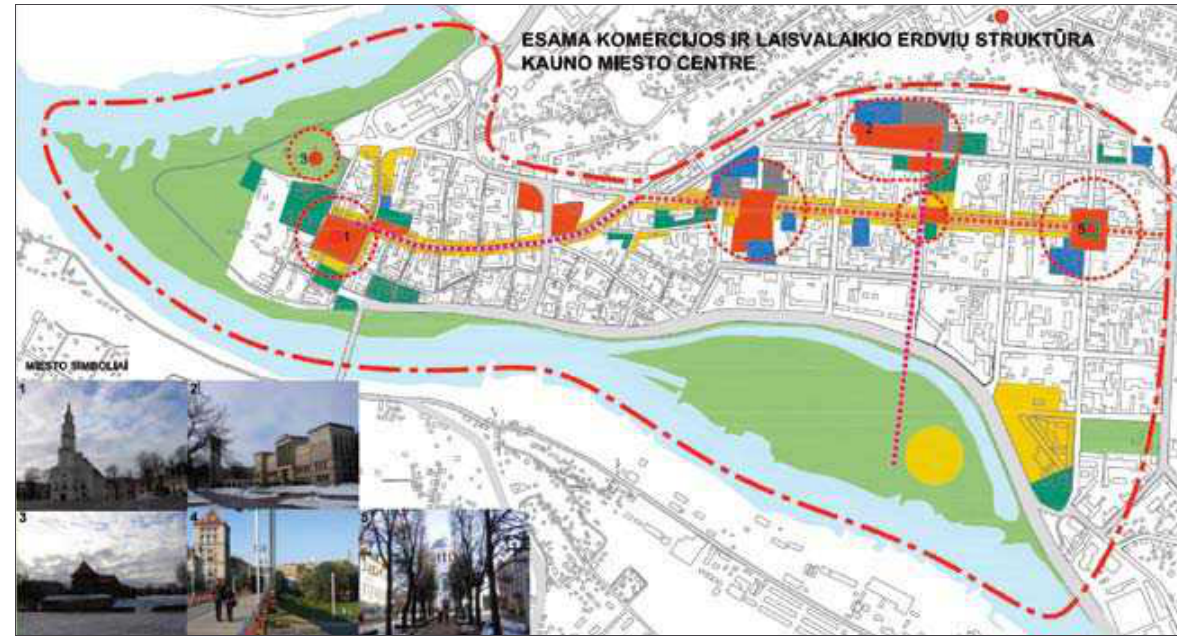
Fig. 3. Present structure of commercial and leisure spaces in kaunas city center (by A. Gabrys